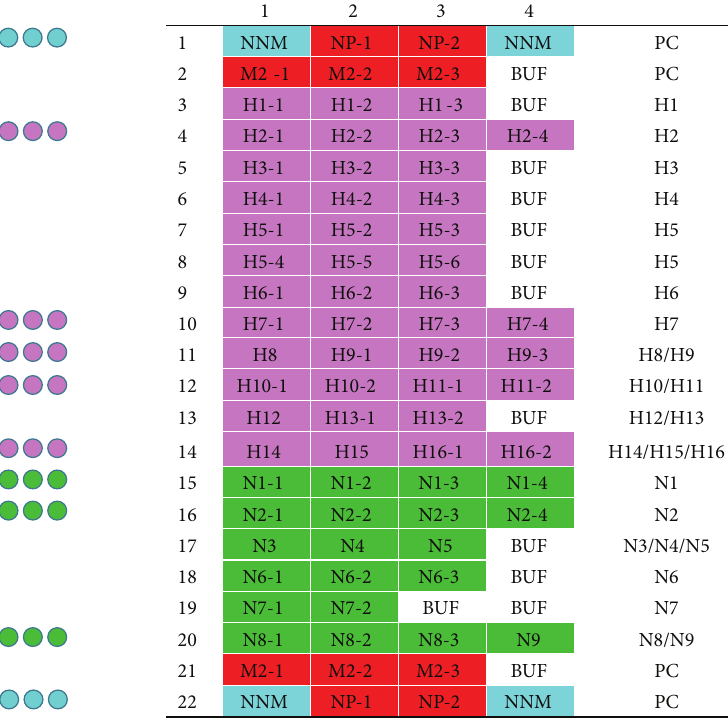
Figure1:SchemeofthemodelIAVchipmicroarrayforinfluenzaAvirussubtyping.H:hemagglutinin,N:neuraminidase,PC:positivecontrol, BUF: 1xMicroarray printing buffer Arrayit, and NNM: hybridization